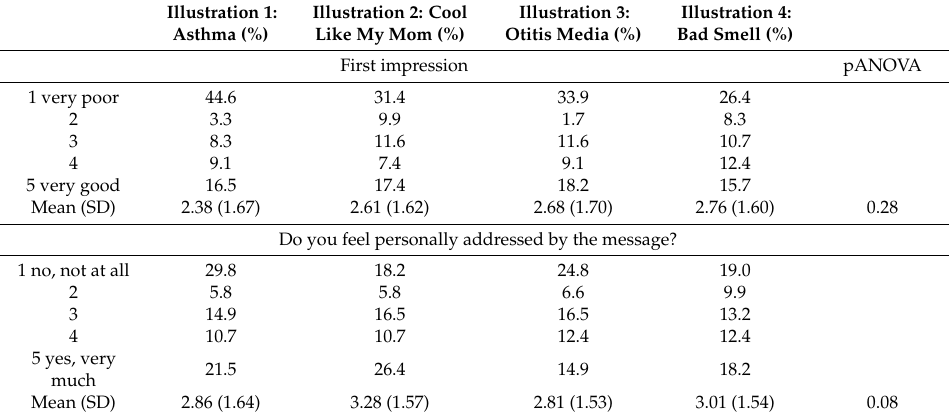
Table 1. Evaluation of the first impression and the appeal of the campaign illustrations by the 121 participants in the quantitative evaluation .